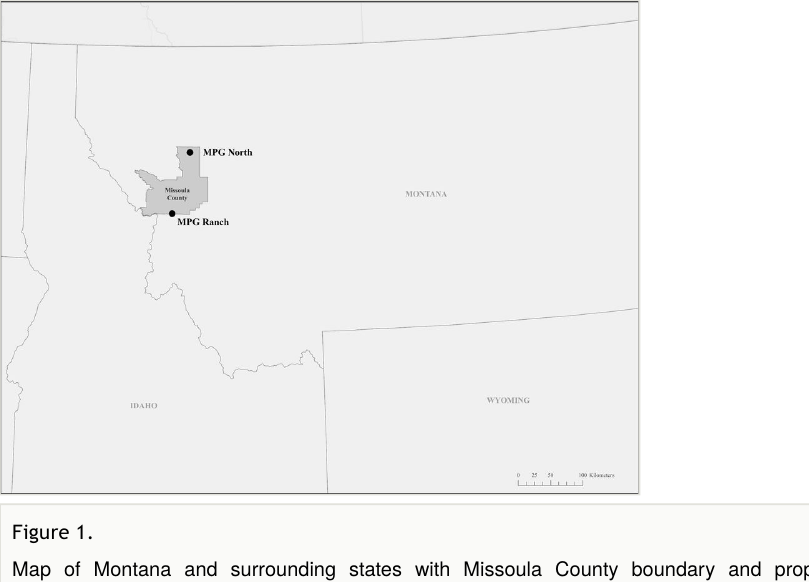
Map of Montana and surrounding states with Missoula County boundary and property locations